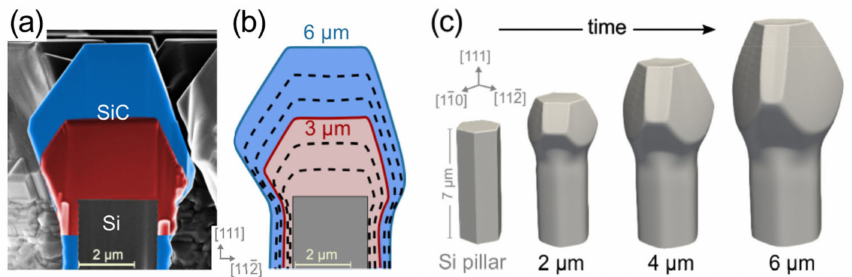
Figure 4. ( a ) SEM (1-10) cross-section view of the upper part of a SiC crystal after 3 µ m (red) and 6 µ m (blue) deposition on top of a 2 µ m-wide Si pillar (gray), which is 8 µ m tall. ( b ) Phase-field simulation profiles for the same conditions of ( a ) reproduced every 1 µ m deposition. ( c ) 3D view of the evolution sequence obtained from simulations (see Reference